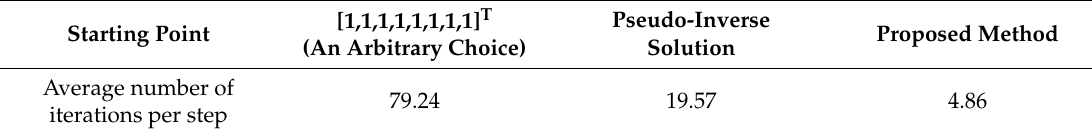
Figure 10. Maximal required actuating torque during the motion ( a ) Forward rotation ( b ) Backward rotation. Table 3. Number of iterations per